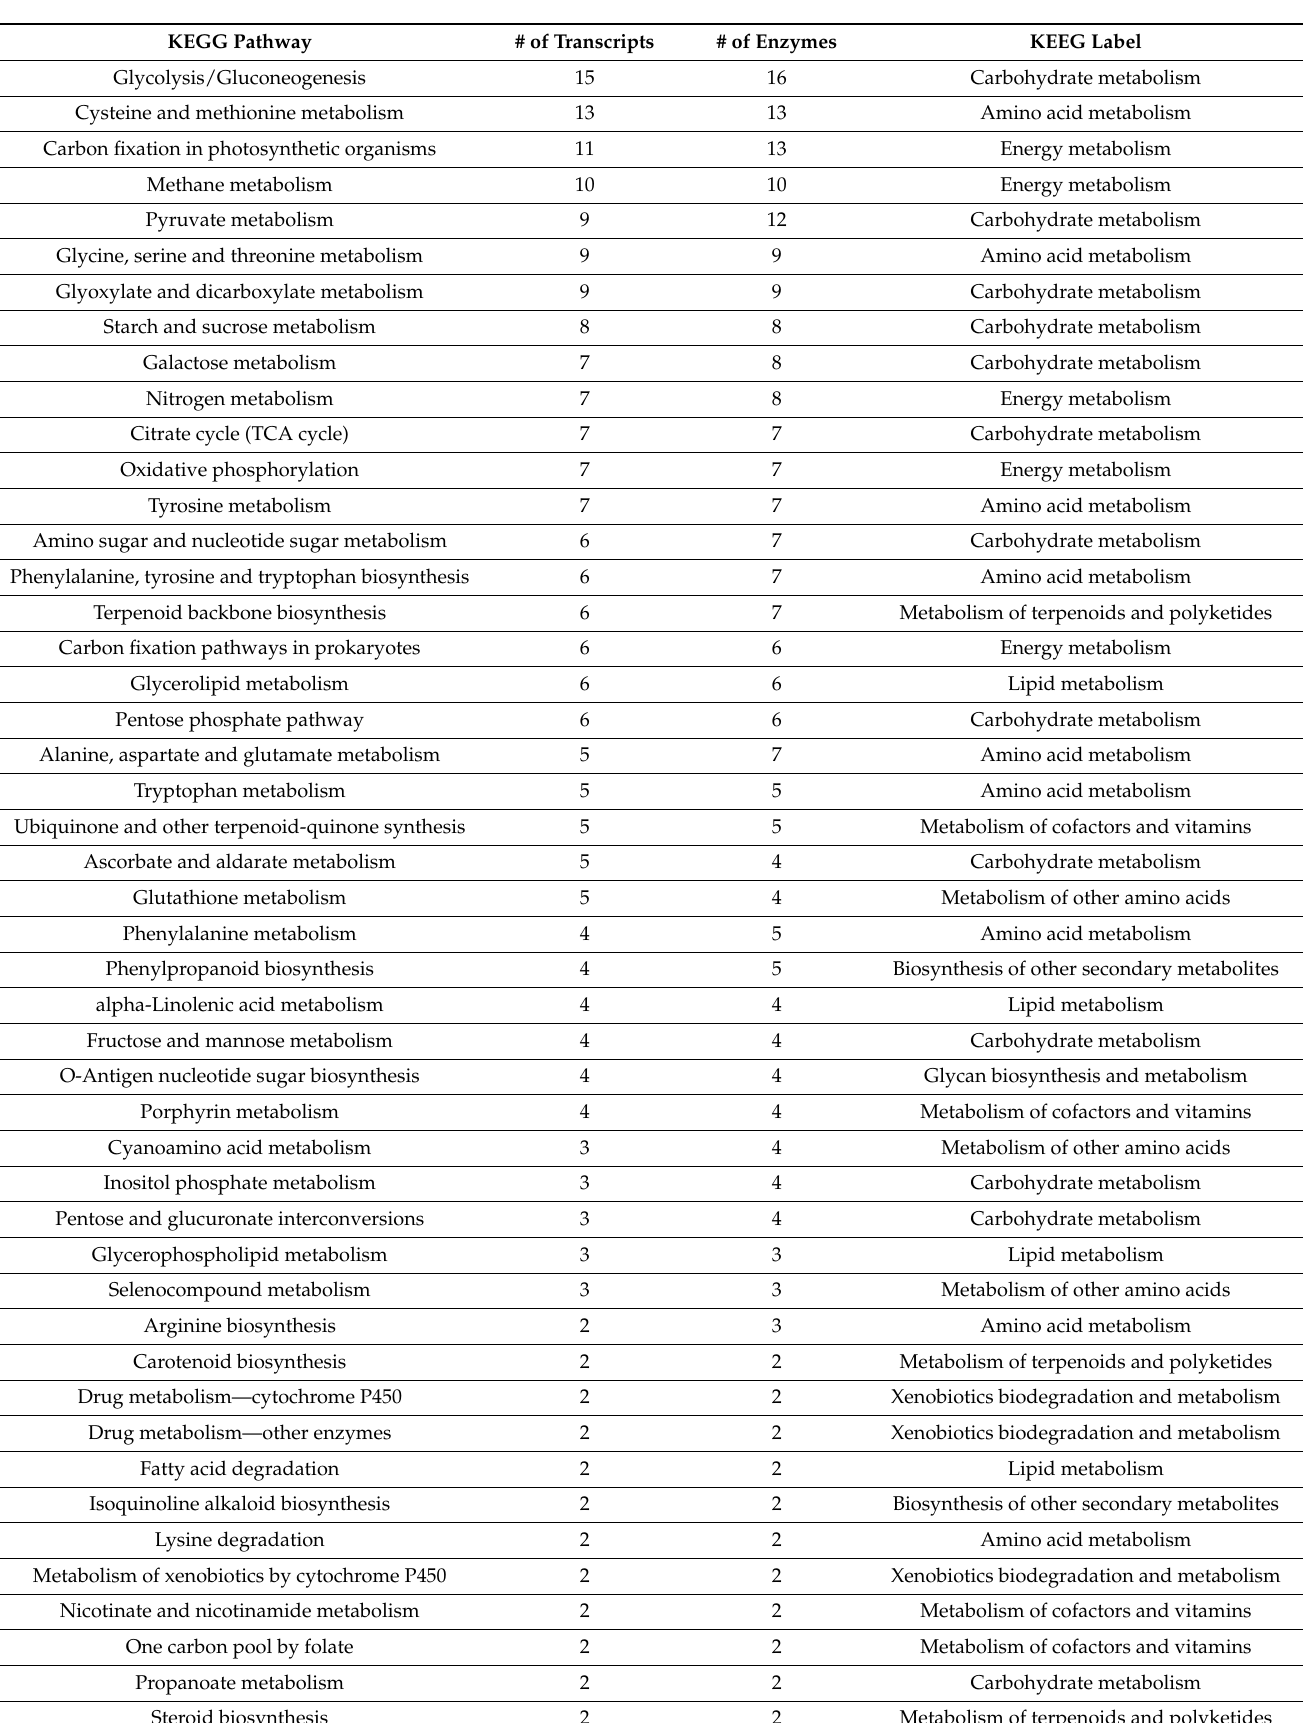
Table 2. Related KEEG pathways (52) across transcripts using enzyme codes in Blas2GO